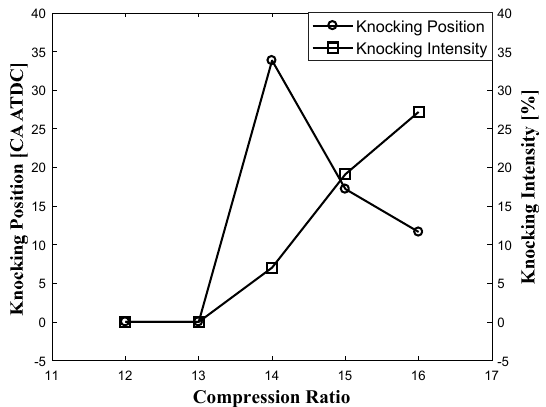
Figure 23. Knocking position and knocking intensity with different compression ratios.